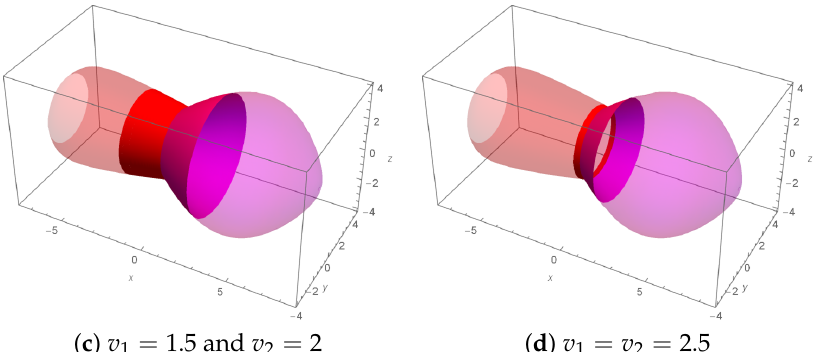
Figure 19. Surface revolution of x -axis of two connected cubic fractional Bézier curves with different shape parameters.